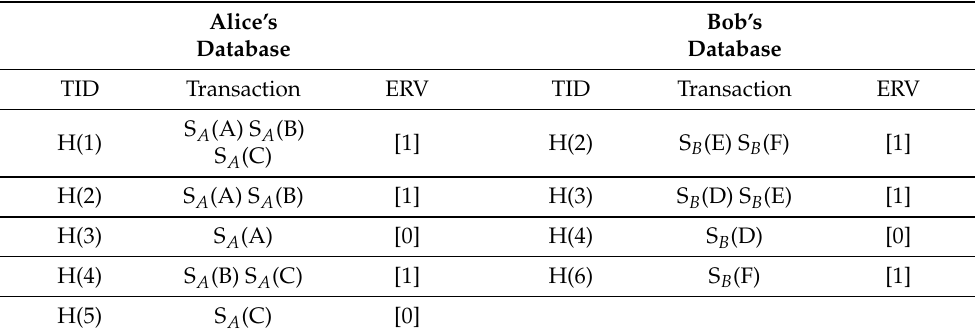
Table 3. Data Owners’ Encrypted Databases.